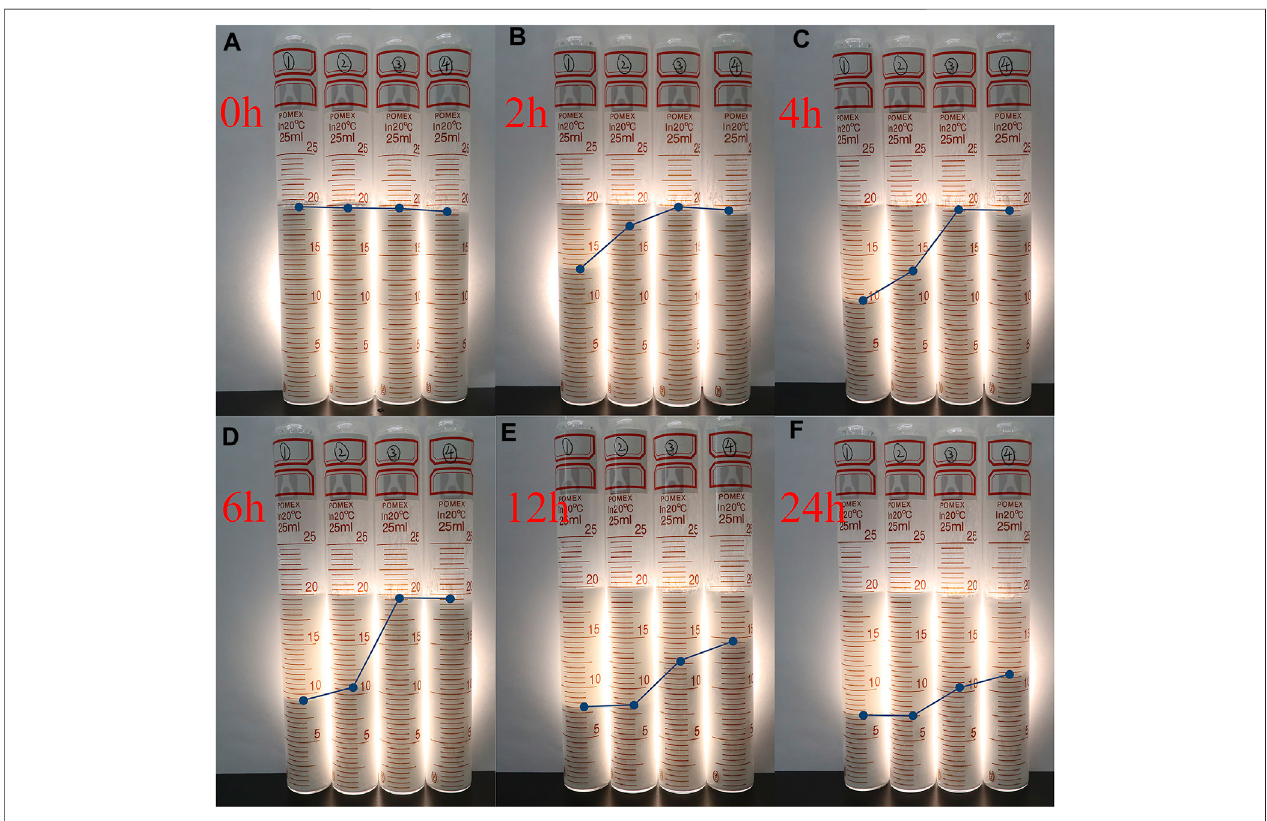
FIGURE6| In fl uenceofMPL onthestabilityofwater-in-oilemulsion.The MPLconcentrationsin each photoare 0,1,2and 3%from lefttoright. Thestanding time is 0 h, 2 h, 4 h, 6 h, 12 h, 24 h for Photo (A – F) ,